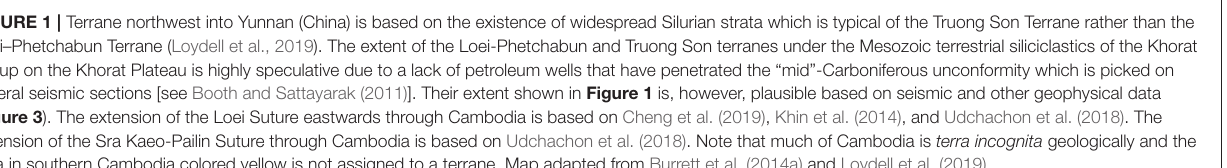
TABLE 1 | Table summarizing main characteristics of each of the Indochina terranes. Loei-Phetchabun Terrane Truong Son Terrane Kontum